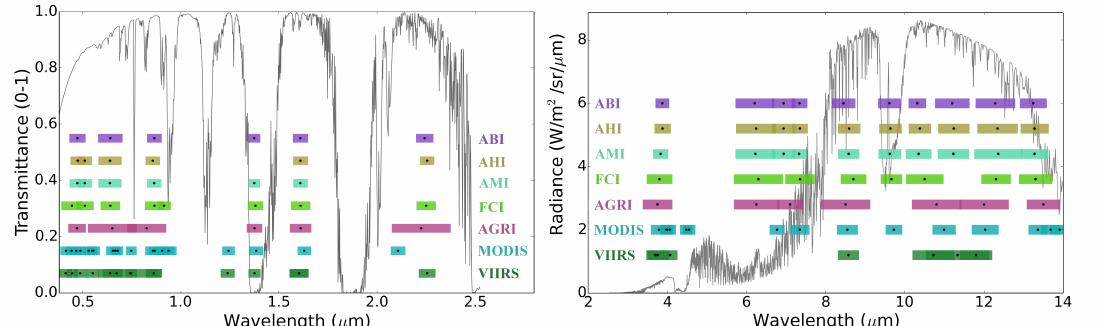
Figure 1. Comparisons of spectral bands across third-generation geostationary sensors: ABI (Advanced Baseline Imager on GOESAHI (Advanced Himawari Imager on the Japanese Himawari 8/9), AMI (Advanced Meteorological Imager on the Korean GEO-KOMPSAT-2A), AGRI (Advanced Geosynchronous Radiation Imager on the Chinese Fengyun-4), and FCI (Flexible Combined Imager on European Meteosat Third Generation) with those of MODIS/VIIRS. The background thin lines show the atmospheric transmittance (for the reflective bands) and the atmospheric radiance of a typical mid-latitude summertime profile (for the emissive